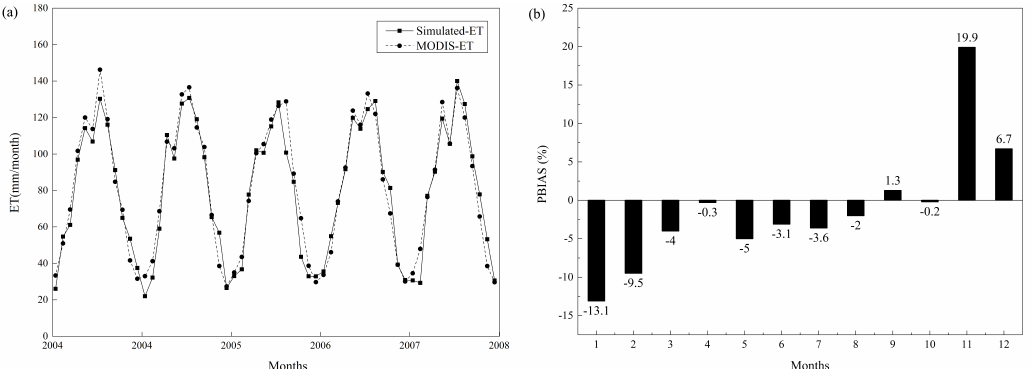
Figure 11. ( a ) Comparison of monthly areal simulated ET and MODIS-ET, and ( b ) PBAIS between simulated-ET and MODIS-ET for solution E from multi-objective calibration.